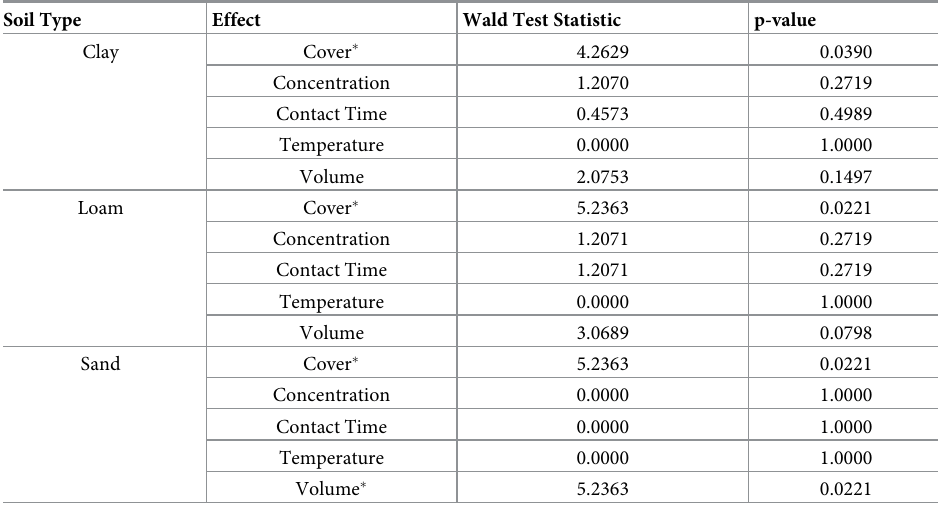
Table 3. Statistical analysis of ability to achieve complete inactivation, by soil